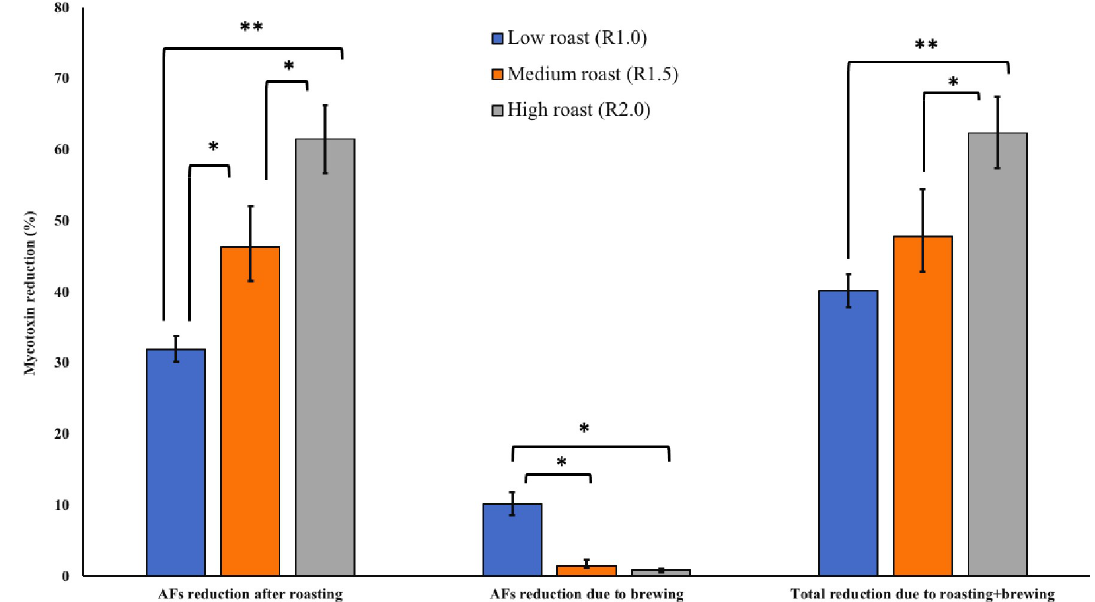
Fig 3. Effect of traditional roasting and brewing on AFs reduction (%) on naturally contaminated coffee beans. The combined effect of roasting and brewing was 40.18% (34.65 μ g/kg), 47.86% (41.17 μ g/kg) and 62.38% (53.73 μ g/kg) reduction in the AFs levels in the coffee samples roasted at traditionally low, medium and high methods, respectively.